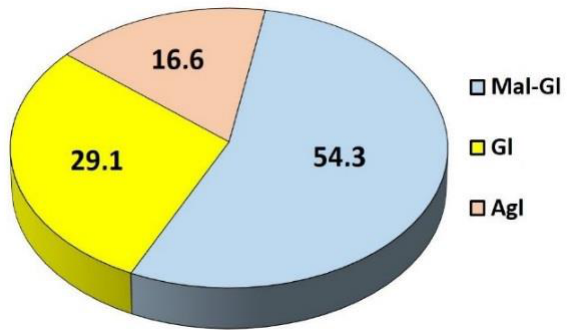
Figure 4. The average ( n = 9) percentage of isoflavone aglycones ( Agl ) and their derivatives, including glycosides ( Gl ) and malonylglycosides ( Mal-Gl ), per total isoflavone content determined in TML.